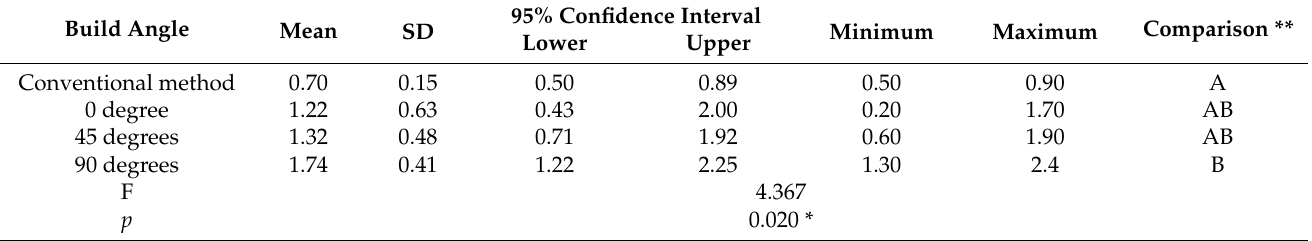
Figure 4. Comparison of the root mean square and wear volume according to build angle: ( A ) root mean square and ( B ) wear volume. The letters (a and b) were determined using Tukey’s HSD test; p < 0.05. Table 4. Comparison of the wear of interim crowns fabricated according to build angle (volume (mm 3 )).